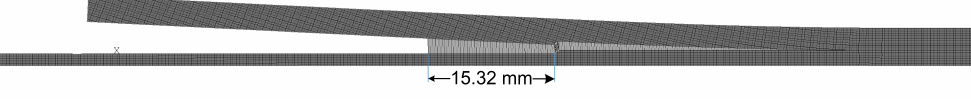
Figure 11. The position of delamination